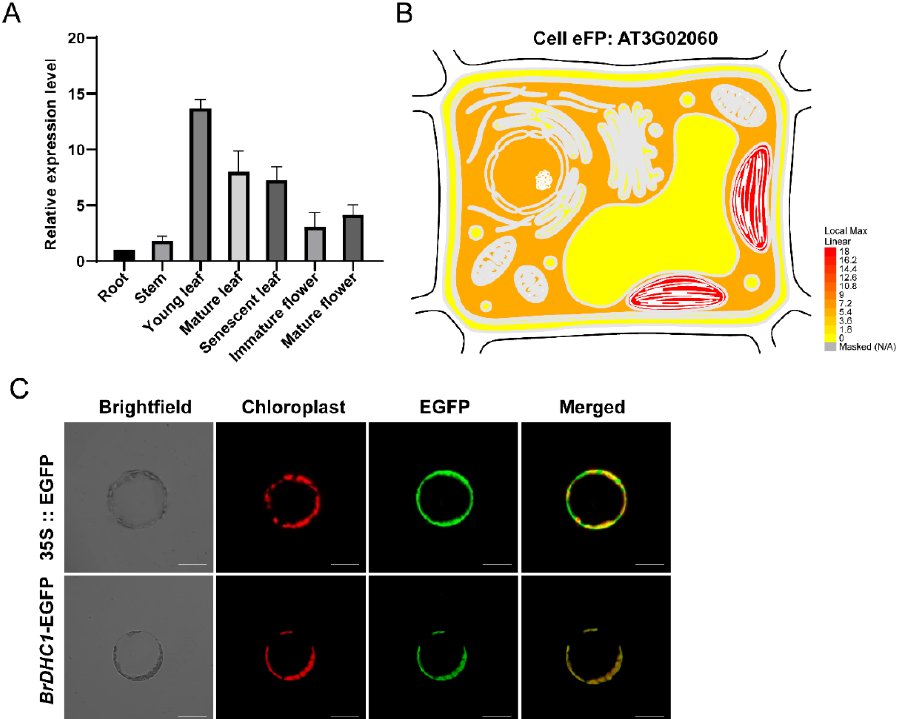
Figure 2. Expression and subcellular localization analysis of BrDHC1. ( A ) BrDHC1 gene expression detected by real-time fluorescence quantitative PCR (data represent the means ± SD of 3 replicates). ( B ) Subcellular localization prediction of At3g02060 (homologous gene of Bra040707 in Arabidopsis) through ePlant. ( C ) Subcellular localization of BrDHC1 (fused BrDHC1 -EGFP, pCAMBIAsuper1300- BrDHC1 -EGFP) in Nicotiana benthamiana leaf protoplasts. The pCAMBIAsuper1300-EGFP construct is used as the control. Bars = 40 μ m.